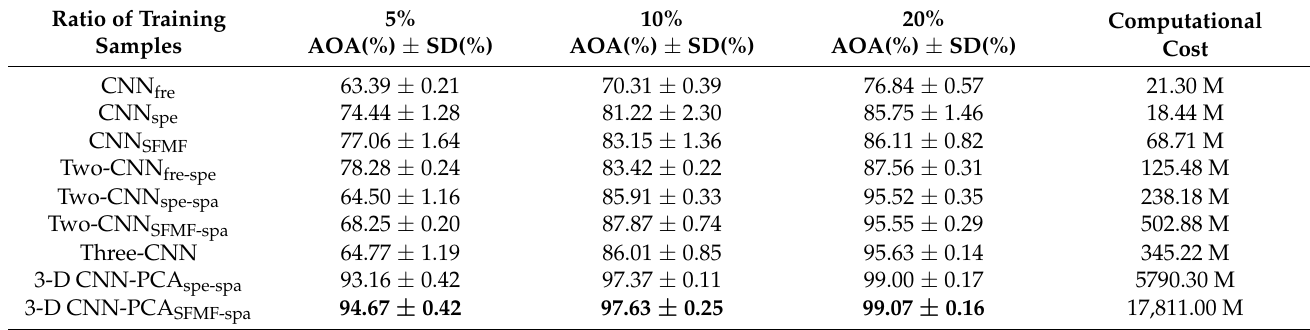
Table 3. Classification results of Indian Pines